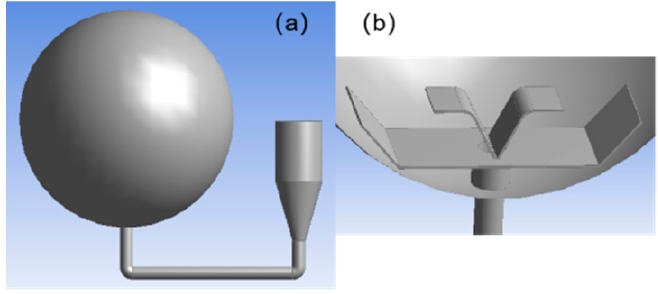
Figure 3. 3D geometric model for ( a ) appearance of 20 L apparatus and ( b ) rebound nozzle.